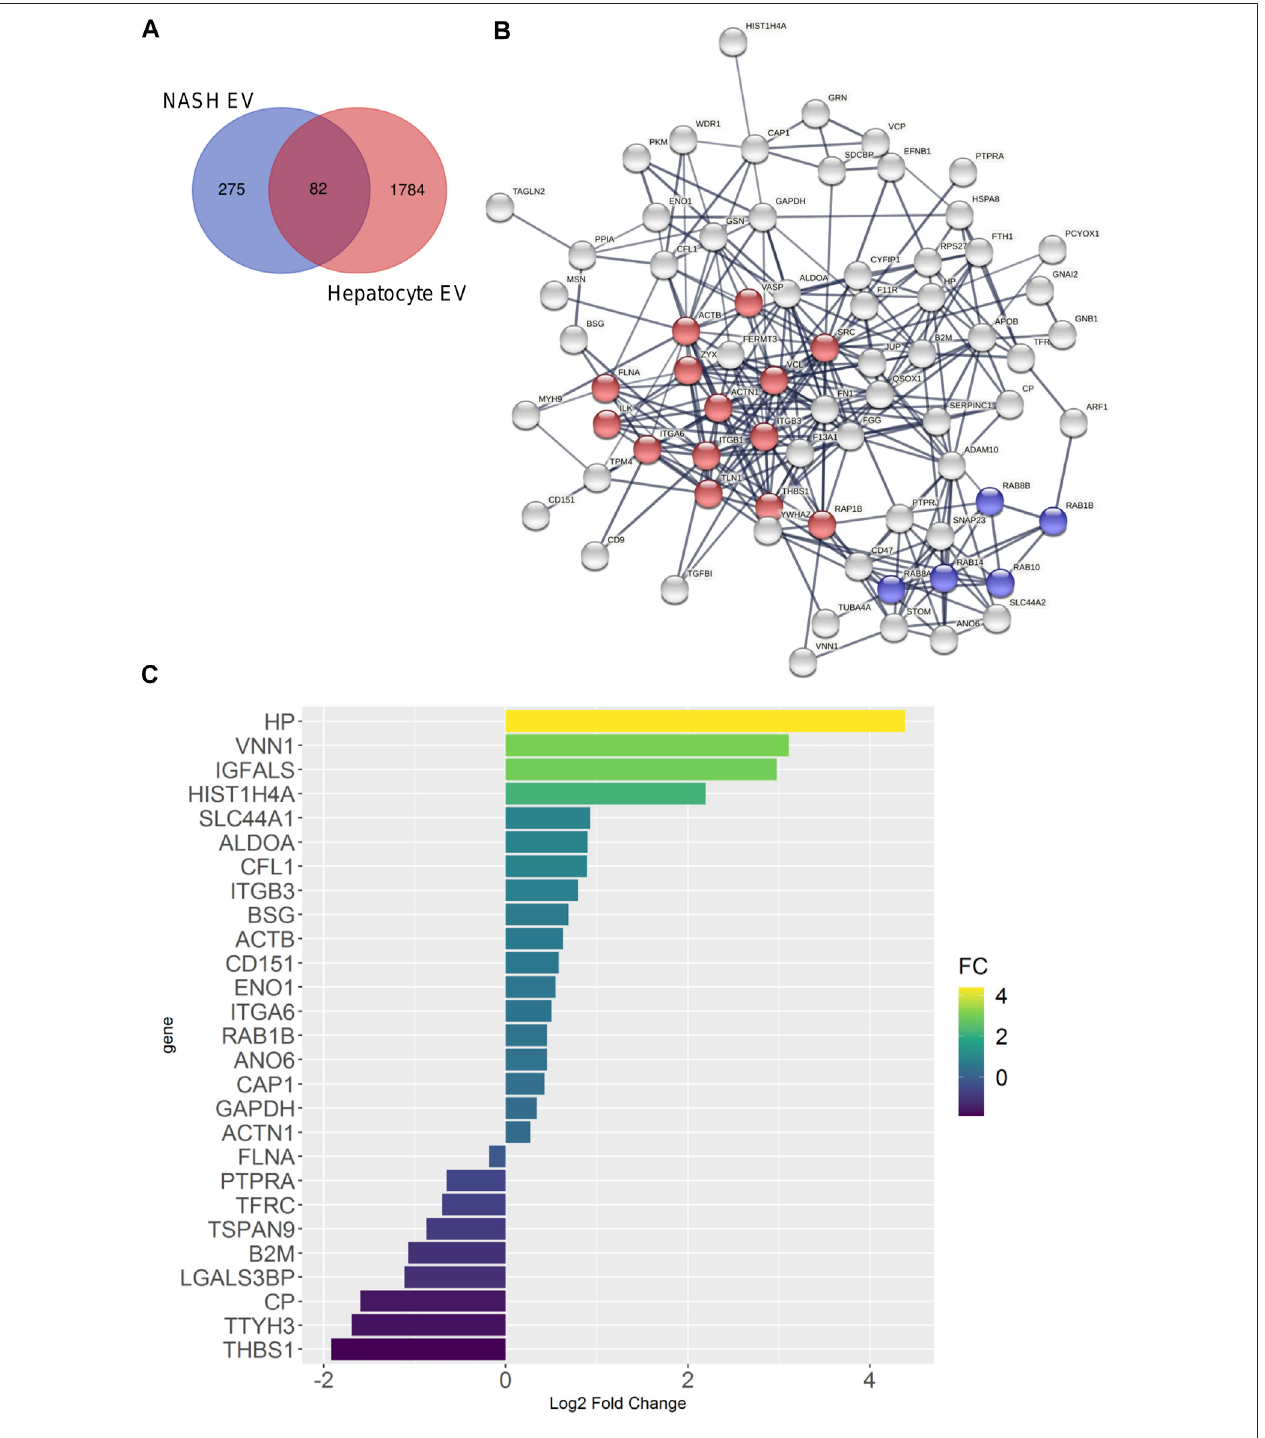
FIGURE 8 | Comparison of palmitate-stimulated EV proteins with NASH plasma EV proteins. (A) Venn diagram compared 357 proteins of human NASH plasma EVsand1,866proteinsofmousehepatocyte-derived,palmitate-stimulated EVs. (B) Protein – proteininteractionanalysiswasperformedbySTRINGsoftware;theedges indicate both functional and physical protein associations; line thickness indicates the strength of data support; we used minimum required interaction score with high con fi dence (0.700); disconnected nodes in thenetworkwereexcluded;red color represents focal adhesion proteins; blue color represents RAB subfamily ofsmall GTPases proteins; these proteins annotation was done by using KEGG and SMART. (C) Bar graph depicts EV proteins detected in ceramide-dependent palmitate- stimulated lipotoxic EVs and NASH plasma EVs; proteins are shown which had p < 0.05; x -axis and color represents Log2 fold change.